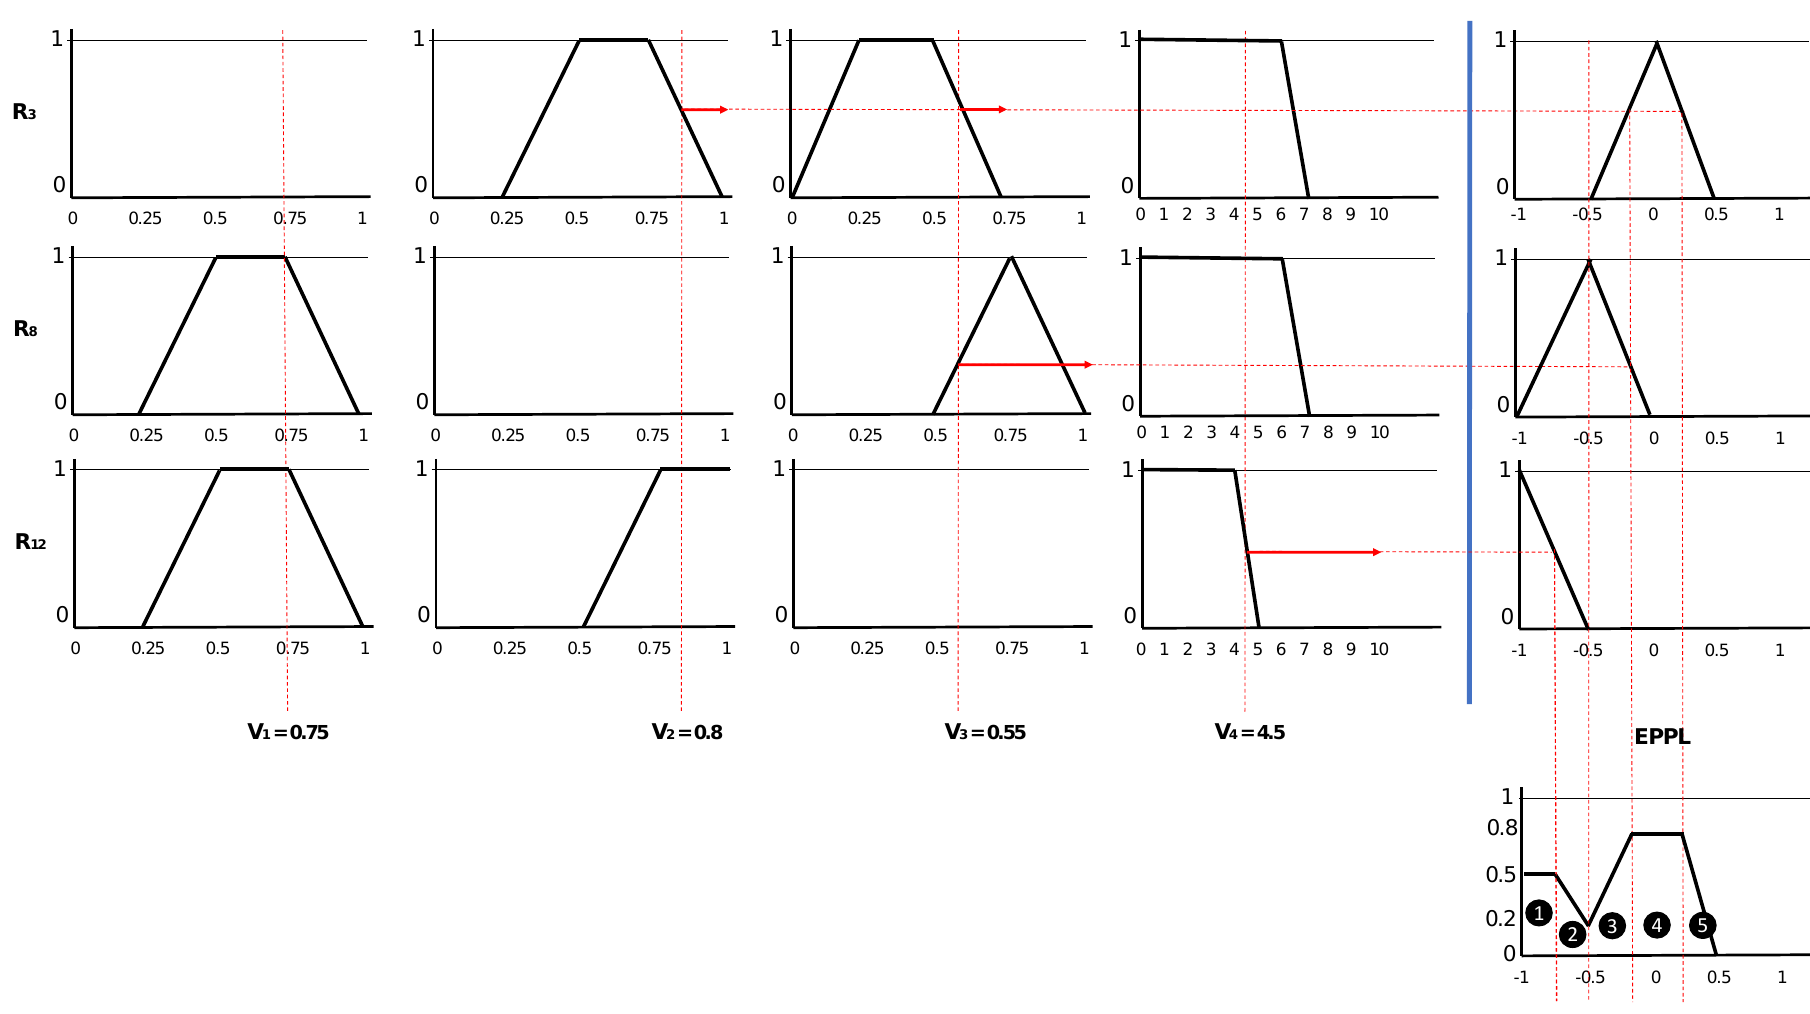
Figure 8. Visual representation and results when applying the aggregation method (max) related to example